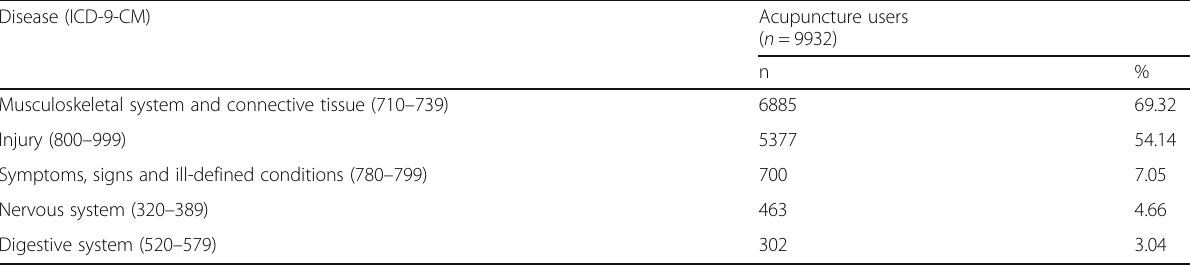
Table 6 The top five disease categories (as the reasons for clinical visits) in acupuncture user cohort Disease